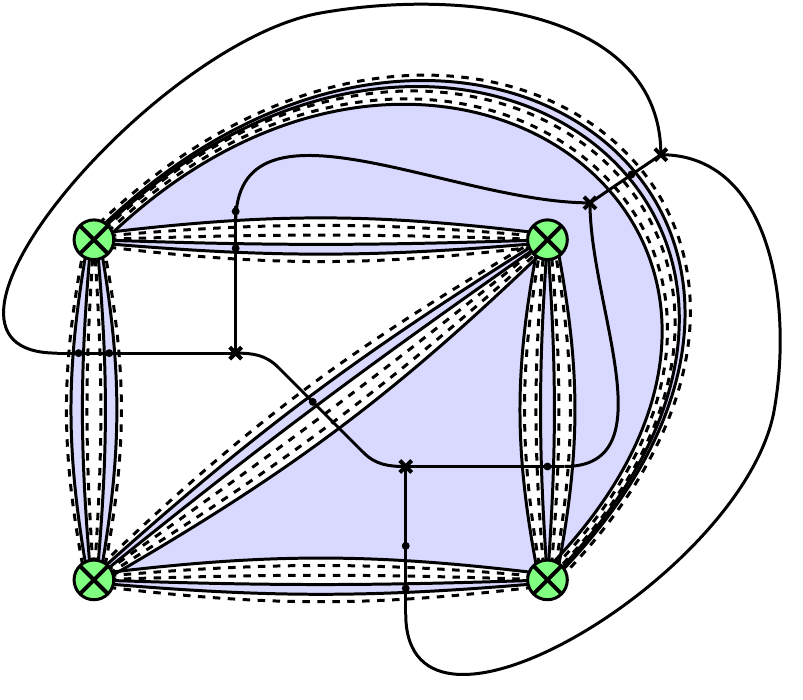
Figure 3 . The Feynman graph for a four-point correlator with w i = 5 and therefore N = 9 . The critical points are denoted by ⊗ . The dual of its skeleton graph, G D , is described by the black solid lines (and its vertices are denoted by crosses); it corresponds to the graph of critical horizontal trajectories of the Strebel differential as discussed in section